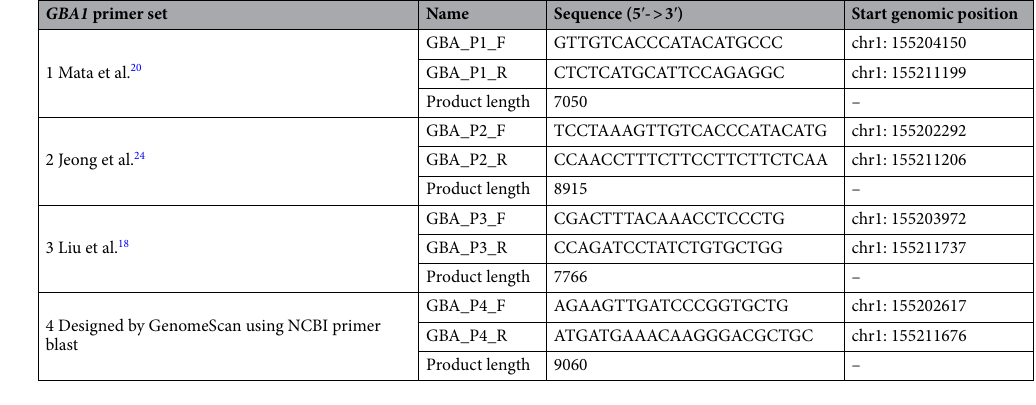
Table 4. Four different GBA1 primer sets that will lead to amplification of the functional gene and not the pseudogene GBAP1. Genomic position based on Hg19.